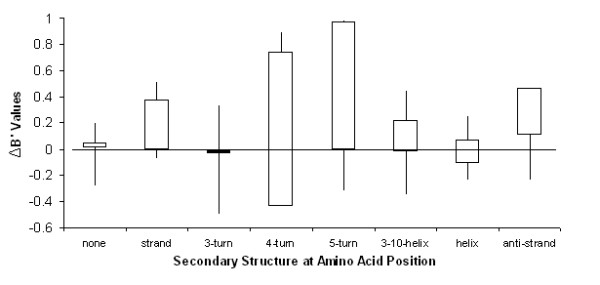
ΔB'-value of each secondary structure. Psychrophiles have greater atom flexibility in strands and 5-turns secondary structure (p < 0.001) compared to mesophilic proteins. * indicates outliers.